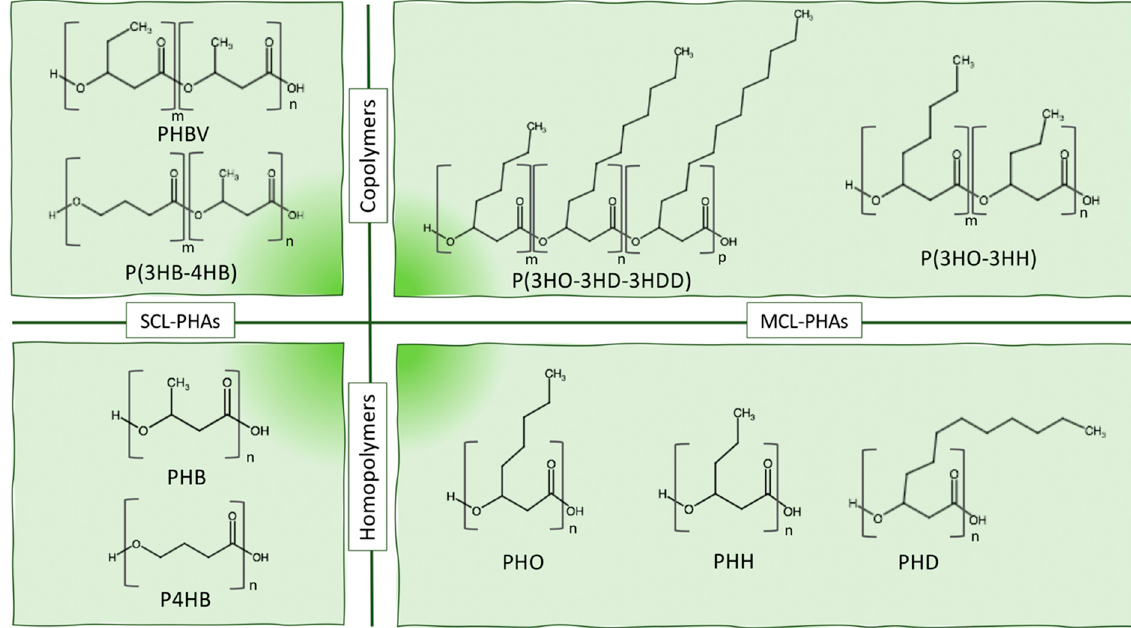
Figure 3. PHAs classification depending on the chain length and the chemical structure of the monomers. PHBV—poly(3-hydroxybutyrate- co -3-hydroxyvalerate); P(3HB-4HB)—poly(3-hydroxybutyrate- co -4-hydroxybutyrate); PHB—poly(3-hydroxybutyrate); P4HB—poly(4-hydroxybutyrate); P(3HO-3HD-3HDD)—poly(3-hydroxyoctanoate- co -3-hydroxydecanoate- co -3-hydroxydodecanoate); P(3HO-3HH)—poly(3-hydroxyoctanoate- co -3-hydroxyhexanoate); PHO—poly(3-hydroxyoctanoate); PHH—poly(3-hydroxyhexanoate); PHD—poly(3-hydroxydecanoate).